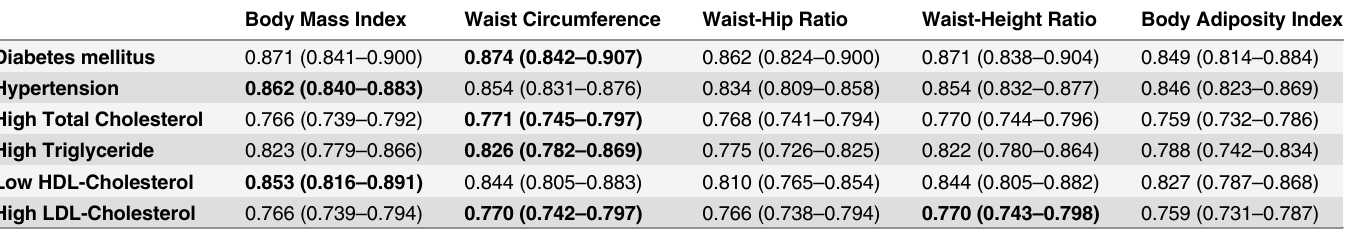
Table 3. Adjusted Area Under Receiver Operating Characteristic (ROC) Curve for the Various Anthropometric Indices and Cardiovascular Disease Risk Factors. Body Mass Index Waist